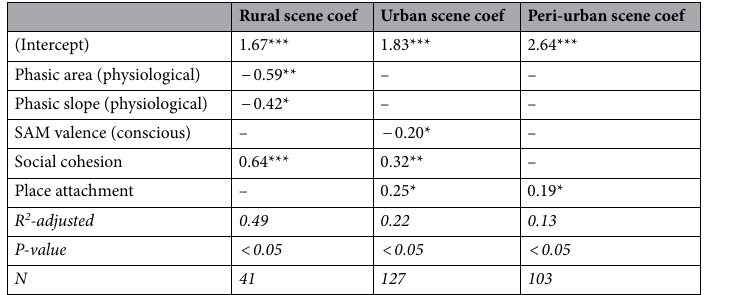
Table 1. Relationships between place-making and emotion-related factors by type of scene. *p < 0.05, **p < 0.01 and ***p <